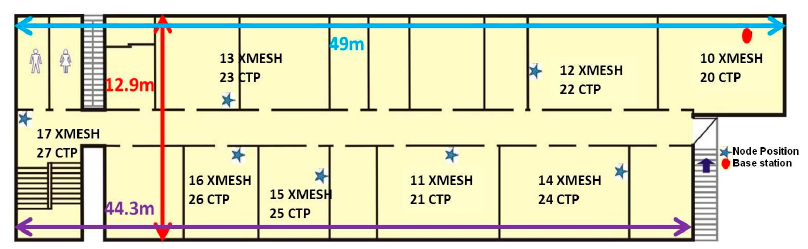
Figure 1. WSN deployment on an upper floor of the CAEND institute.